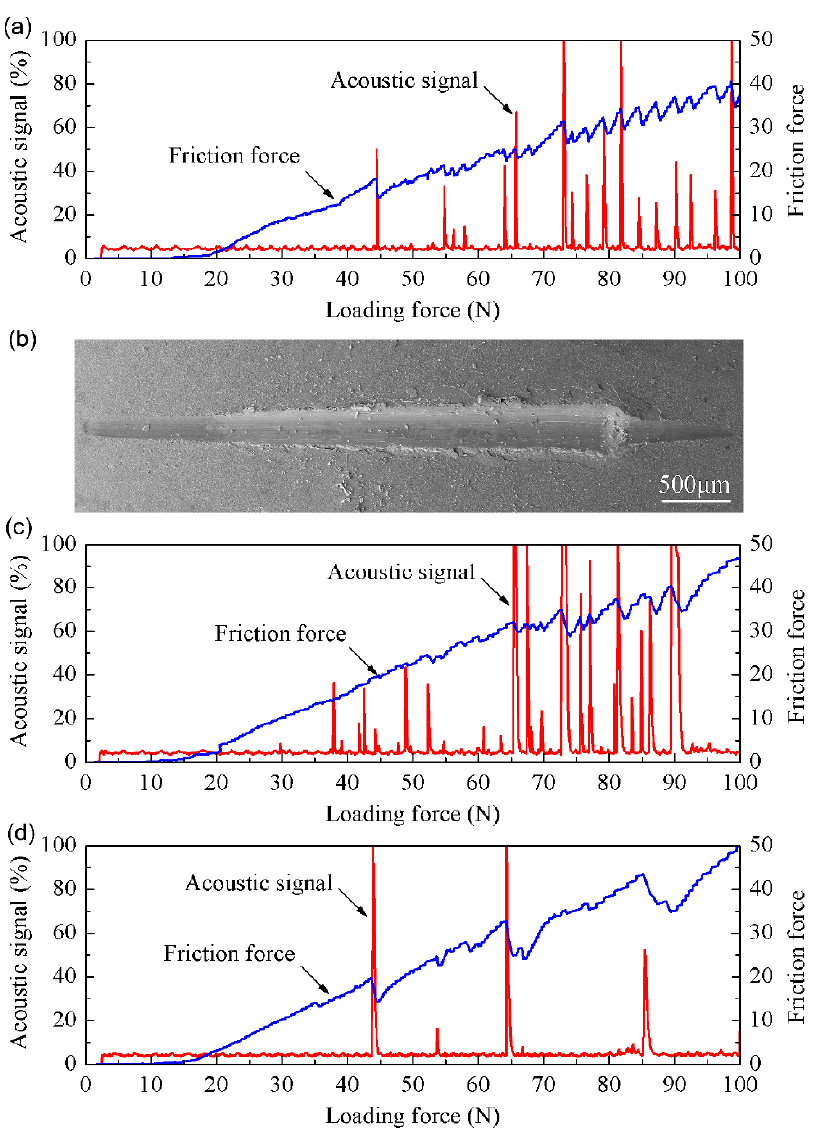
Figure 8. The scratching curves and typical surface morphology of C61900 Cu alloy after plasma nitriding at 650 °C for 4 h: ( a ) the friction force and acoustic signal curve of F1 film, ( b ) the surface morphology of the scratching grooves for F2 film, ( c ) the friction force and acoustic signal curve of F2 film, ( d ) the friction force and acoustic signal curve of F3 film.